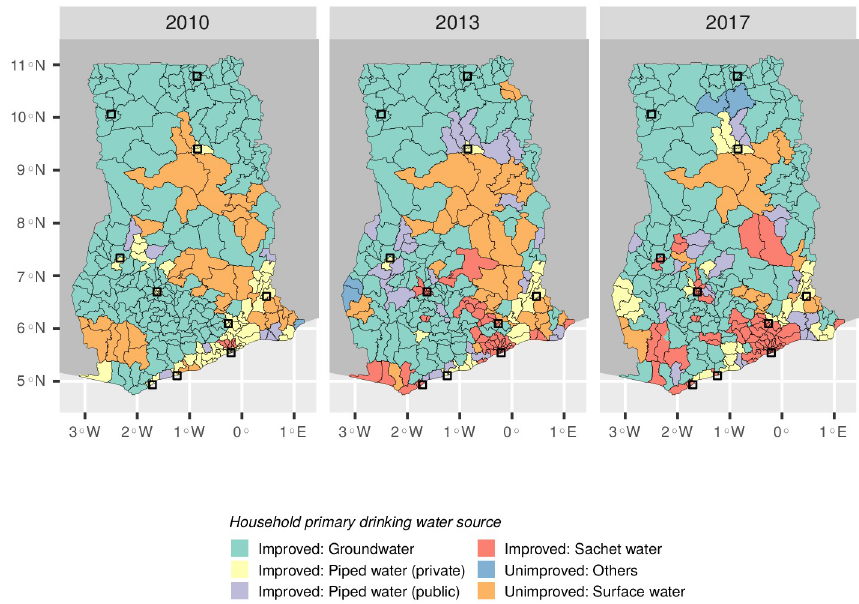
Fig 4. Most common source of drinking water in Ghana’s 170 districts. Maps were created with data from the Humanitarian Data Exchange [33], which are made available under a CC-BY license [34]. For copyright reasons the district boundaries shown are from the present day ( n =